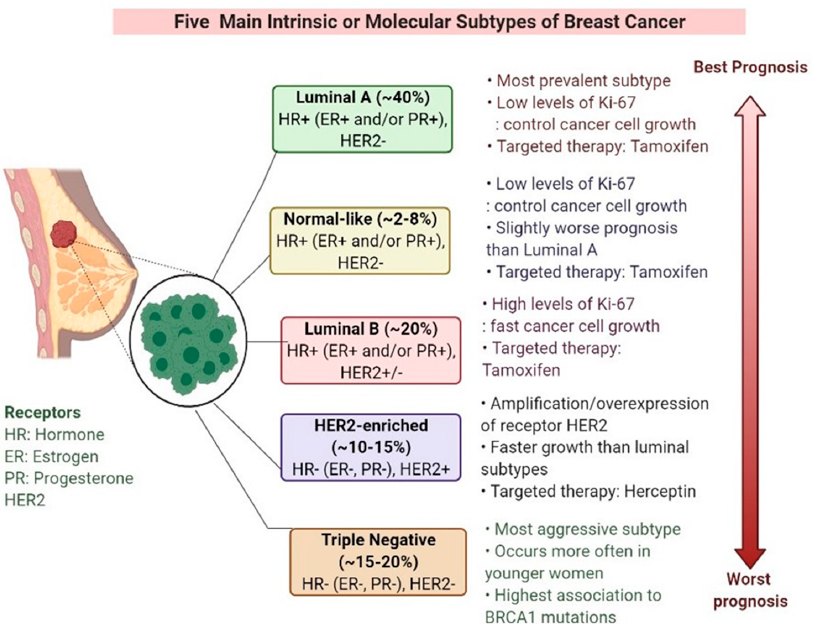
Figure 1. Molecular classification of breast cancer.